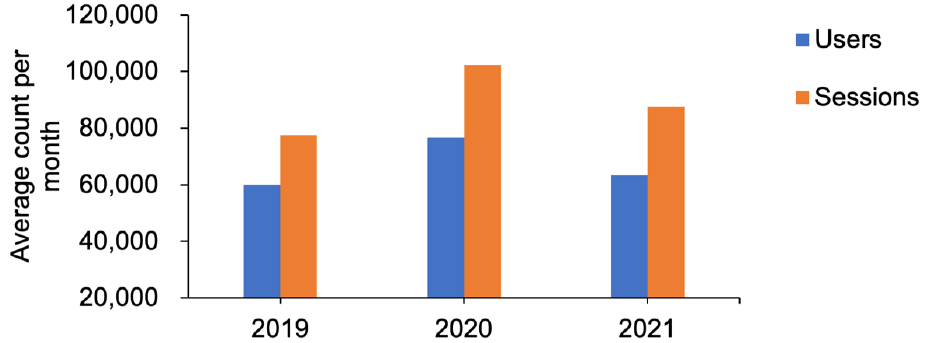
Figure 9. Average monthly usage of PDB-101 (PDB101.RCSB.org, accessed on 28 August 2022) from 2019–2021. Data from Google Analytics.